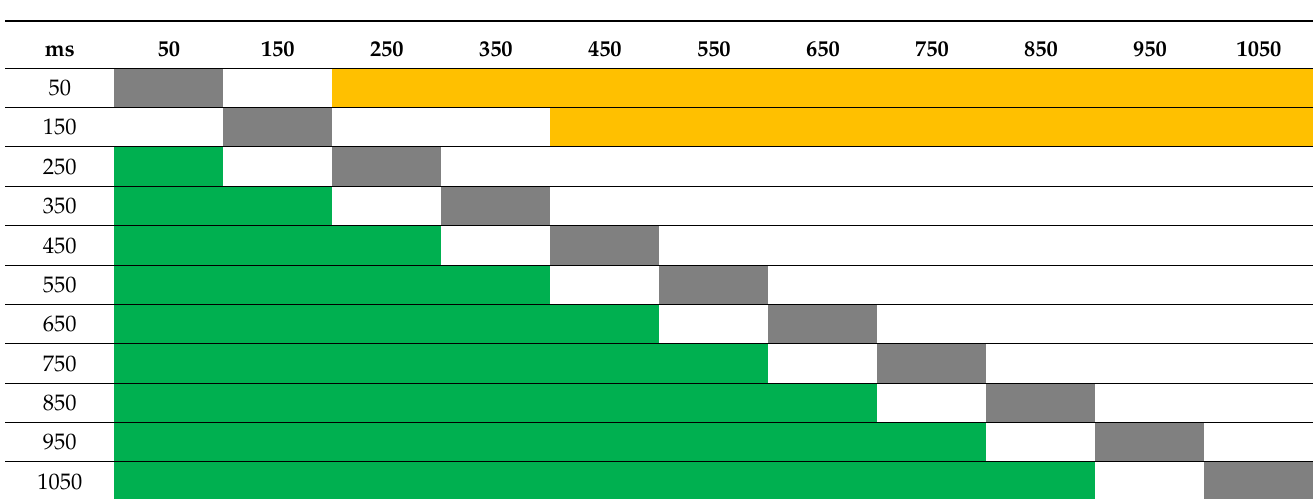
Figure A5. RMSE ( left ) and cross-correlation ( right ) of Ttd algorithm for different window sizes. Table A5. Statistical significance between window sizes for Ttd algorithm. Green indicates statistically significant difference ( p < 0.05; Bonferroni-corrected) for the RMSE metric, and orange indicates significant difference ( p < 0.05; Bonferroni-corrected) for the cross-correlation metric. Grey indicates diagonal fields.